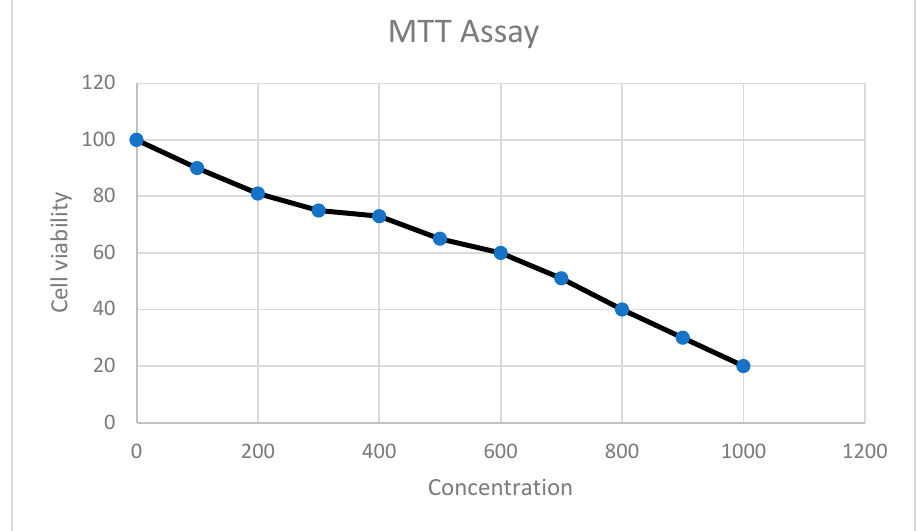
Figure 5. MTT assay results after the treatment with the conjugate.